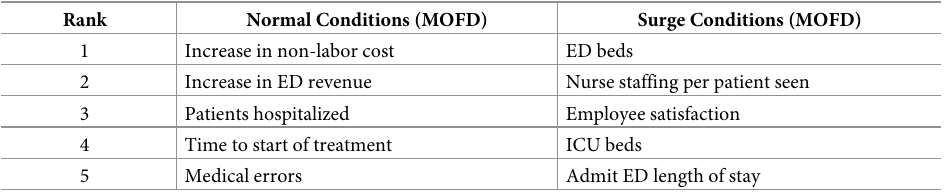
Table 5. Comparing indicators for normal and surge